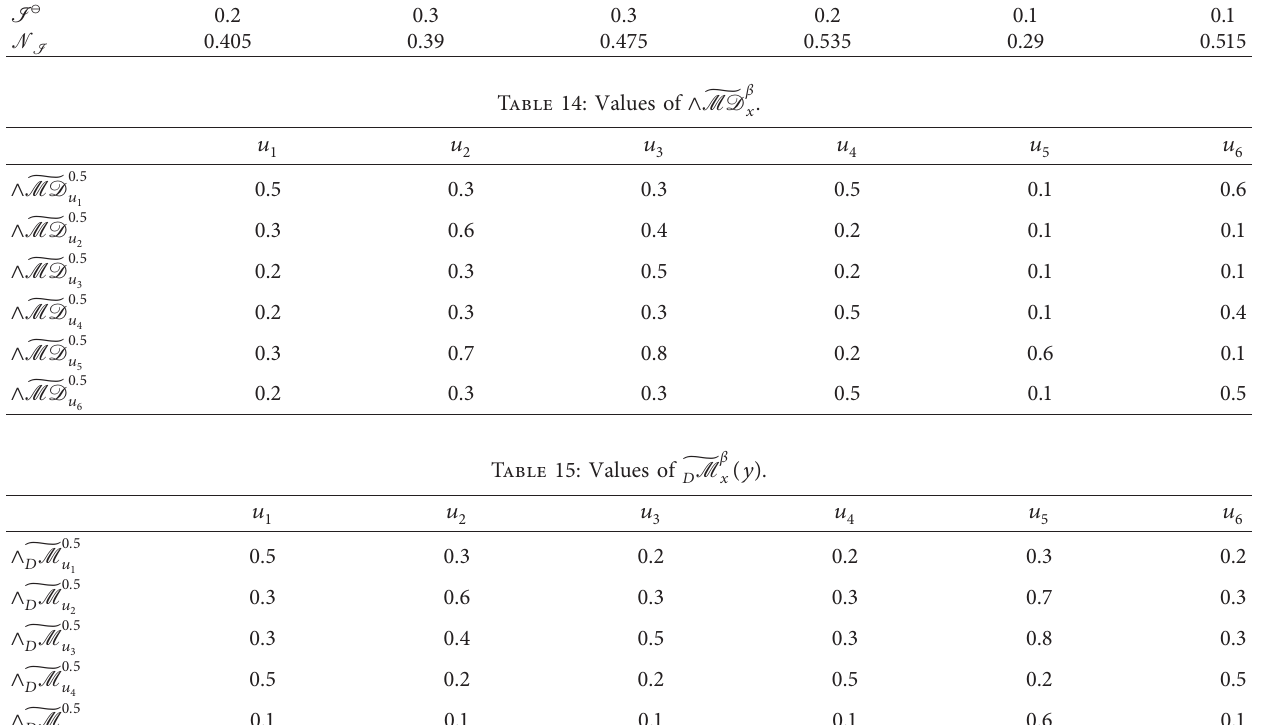
Table 13: Values of I ⊕ , I ⊖ , and N